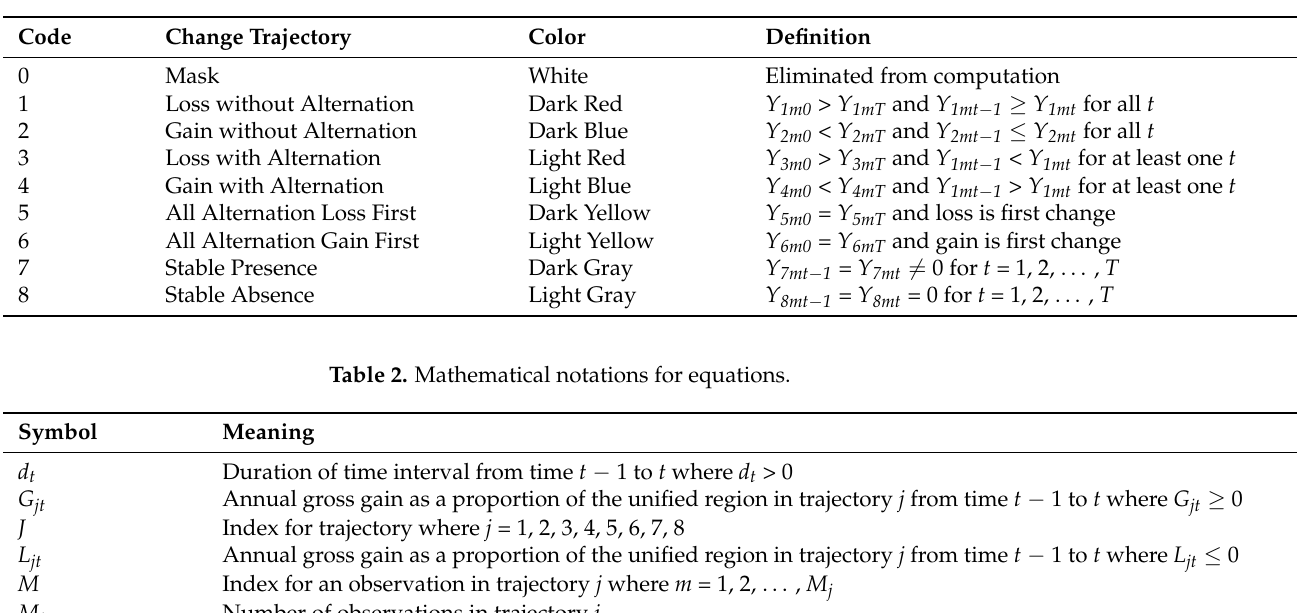
Table 1. Description of the six types of trajectories.